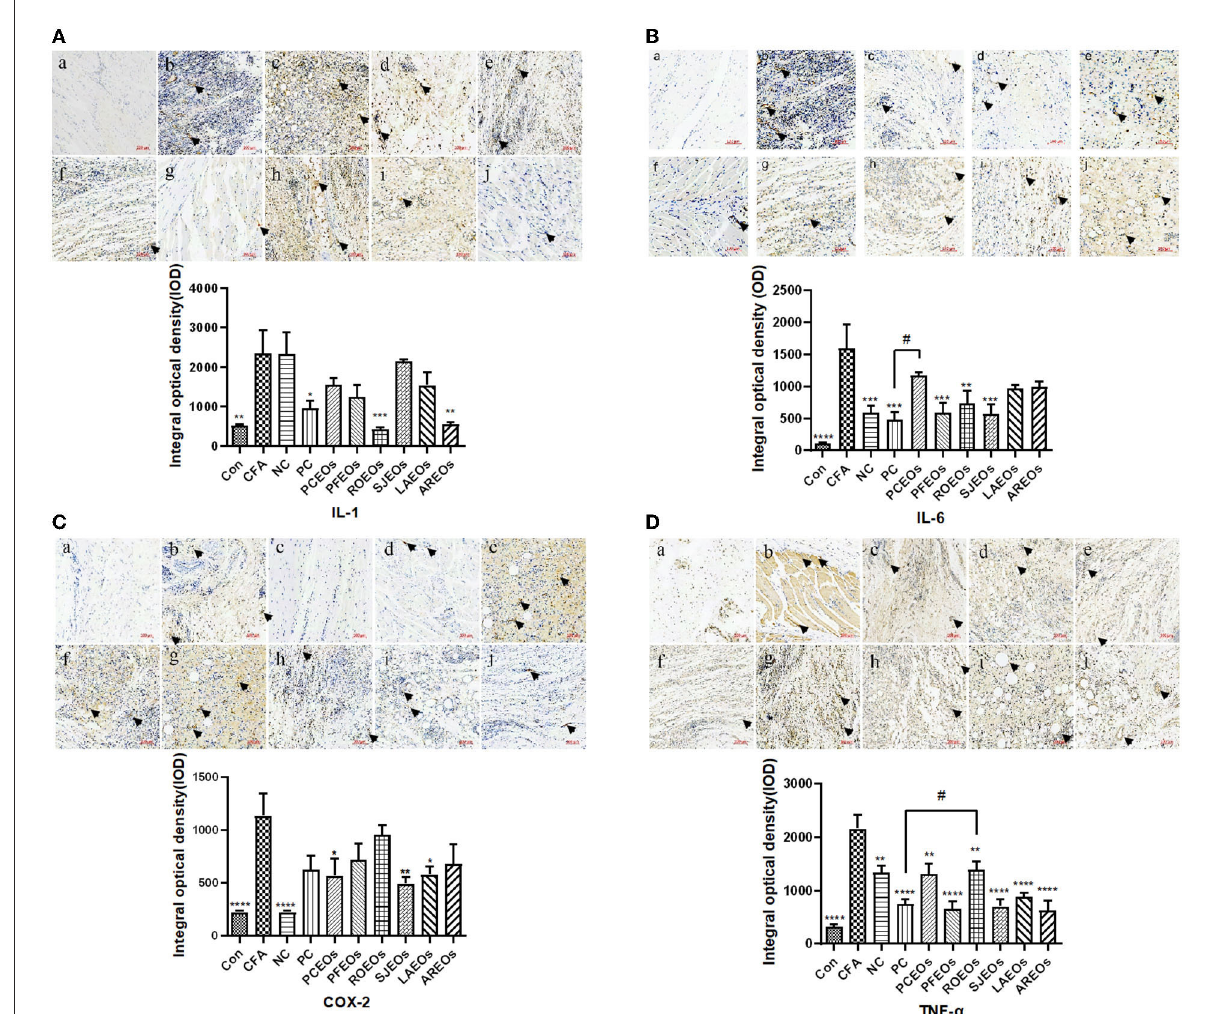
FIGURE6 Immunohistochemical staining of rat articular tissues for COX-2 (A) IL-1 (B) , IL-6 (C) , and TNF- α (D) (200 × magnification). (a) normal control (Con) group, (b) model (CFA) group, (c) negative control (NC) group, (d) positive control (PC) group, (e) PCEO group, (f) PFEO group, (g) ROEO group, (h) SJEO group, (i) LAEO group, and (j) AREO group. Statistical significance relative to the model (CFA) group is indicated, * p ≤ 0.05,** p ≤ 0.01,*** p ≤ 0.001,**** p ≤ 0.0001 , significantly different from the model (CFA) group. Arrows indicate the lesion sites. Statistical significance relative to the positive control (PC) group is indicated, # p ≤